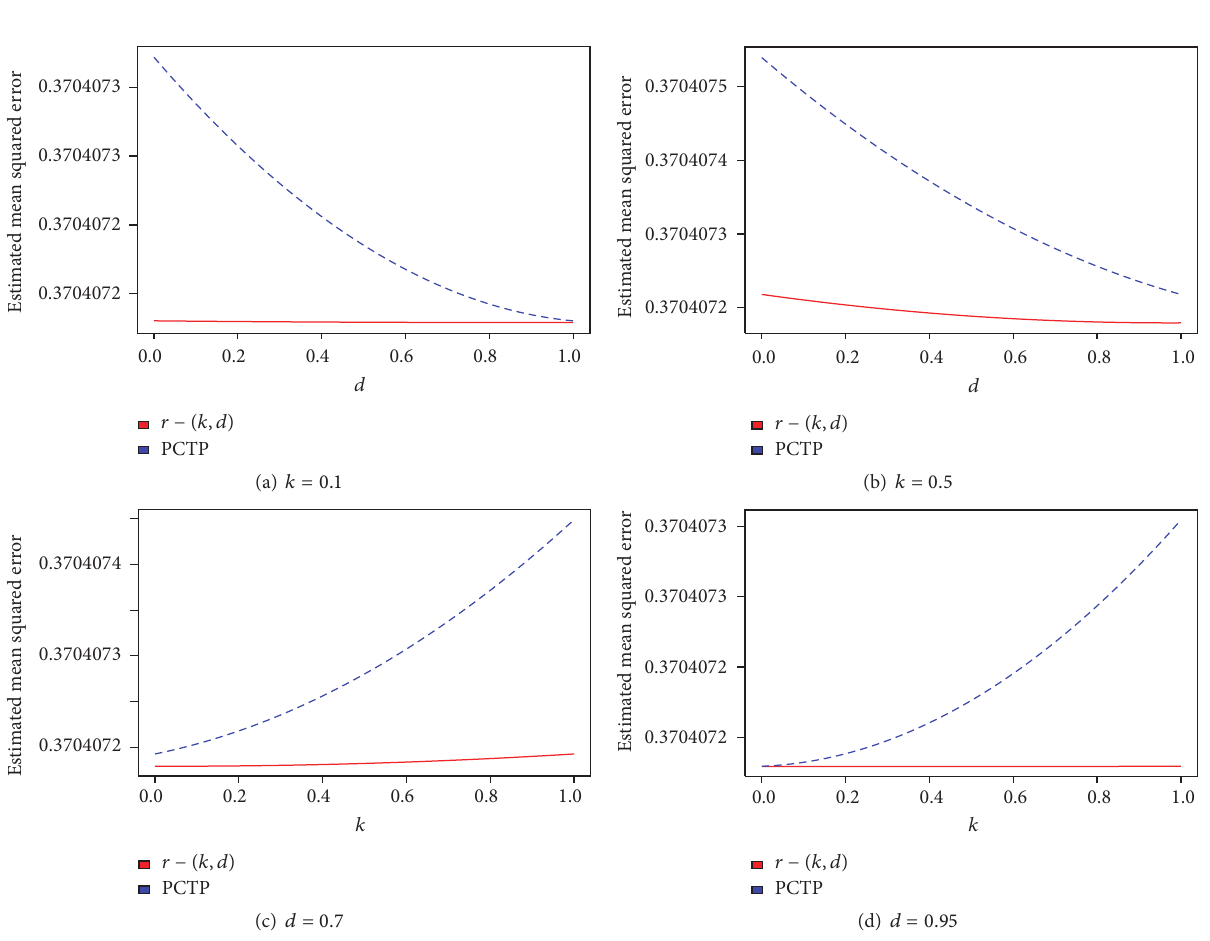
Figure 2: Estimated mean squared error of 𝑟 − (𝑘,𝑑) class and the PCTP estimators for Hald